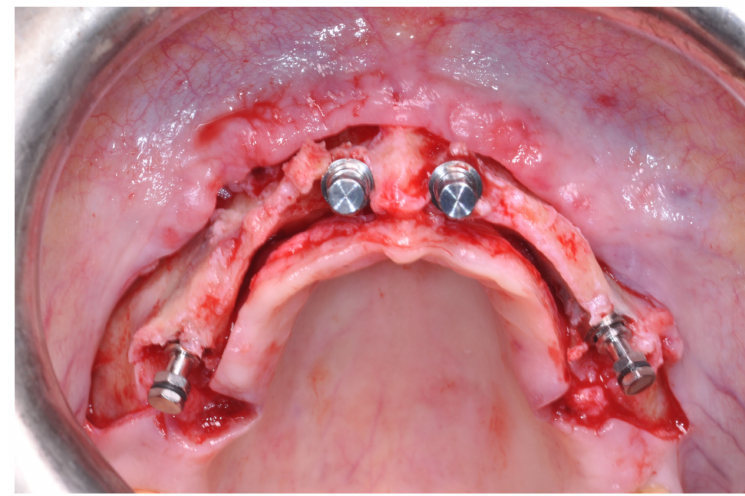
Figure 9. Occlusal view after implant placement.